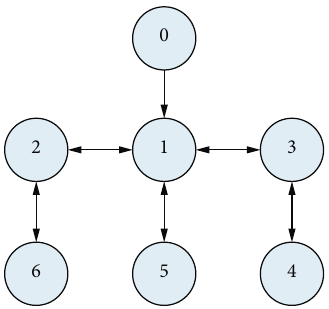
Figure 1: Topology graph (0 indicates the